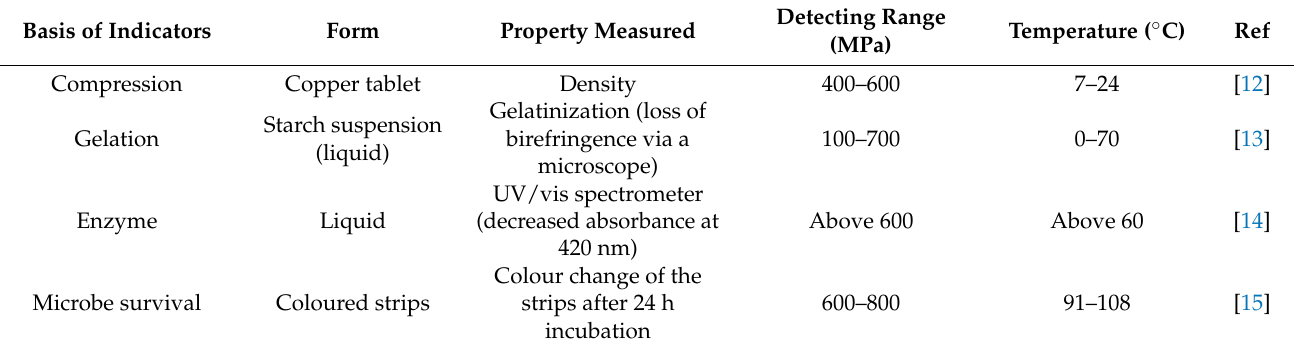
Table 1. Types of reported HPP